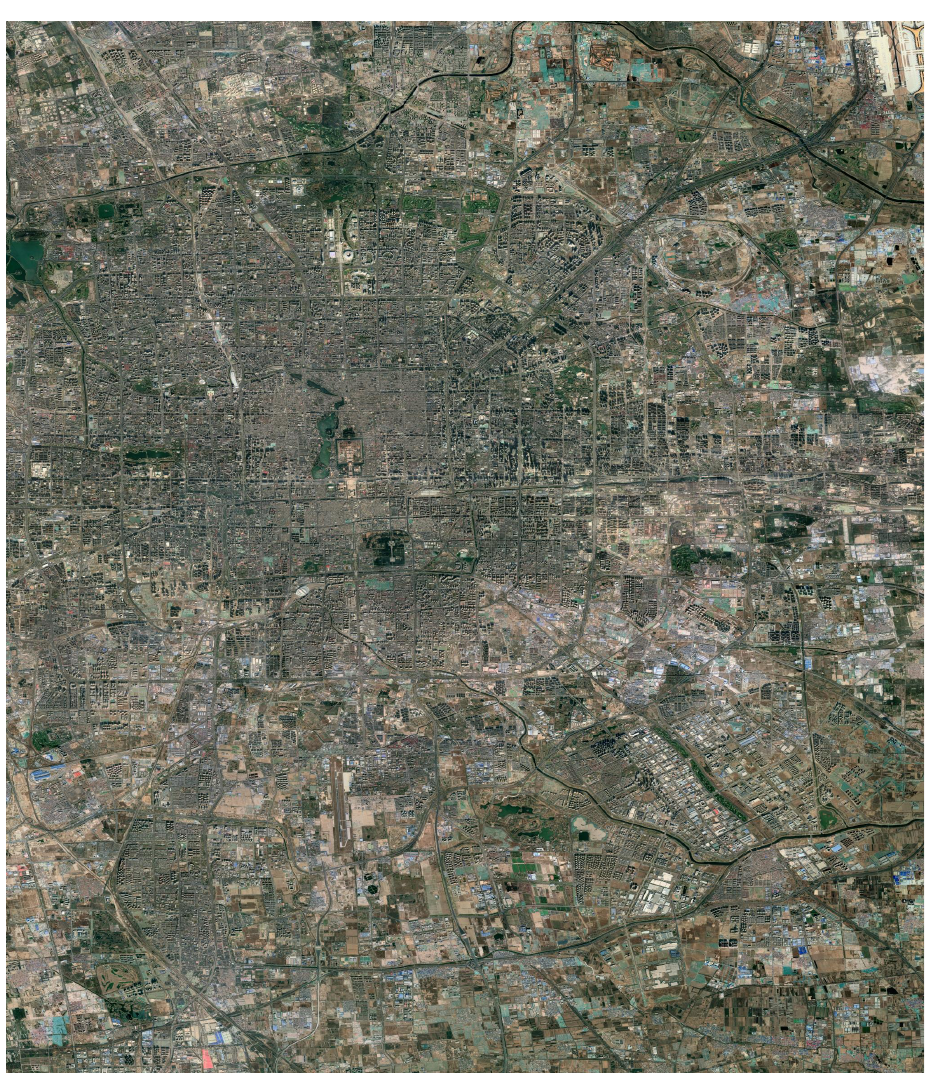
Figure A1. The Google Earth image of the study